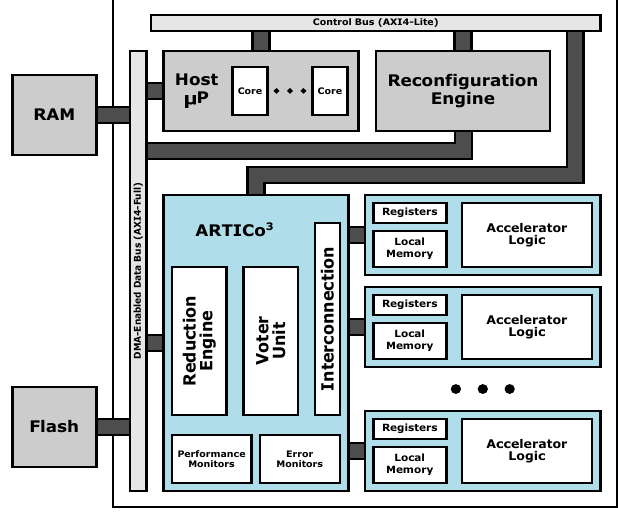
Figure 5. ARTICo 3 architecture